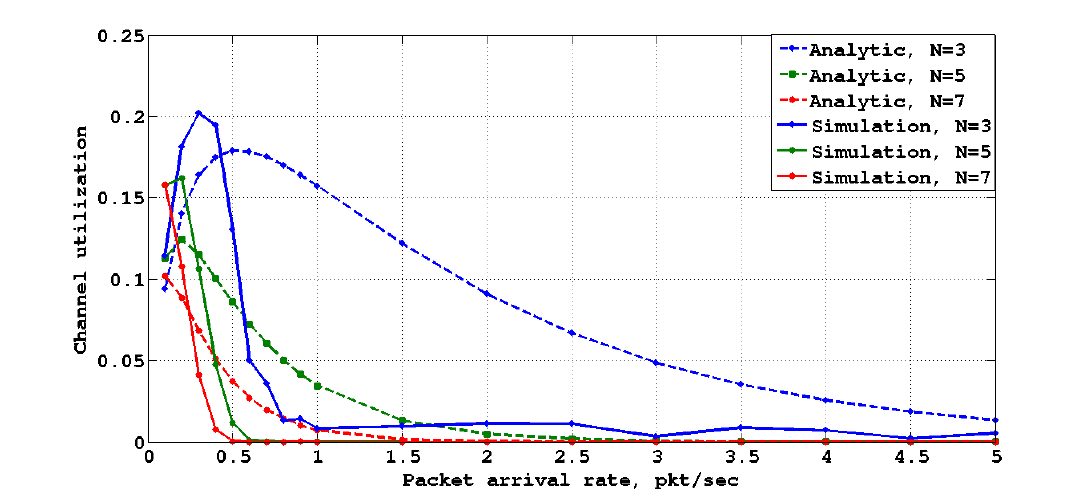
Figure 13. Simulation vs. quantitative analysis for T-Lohi.